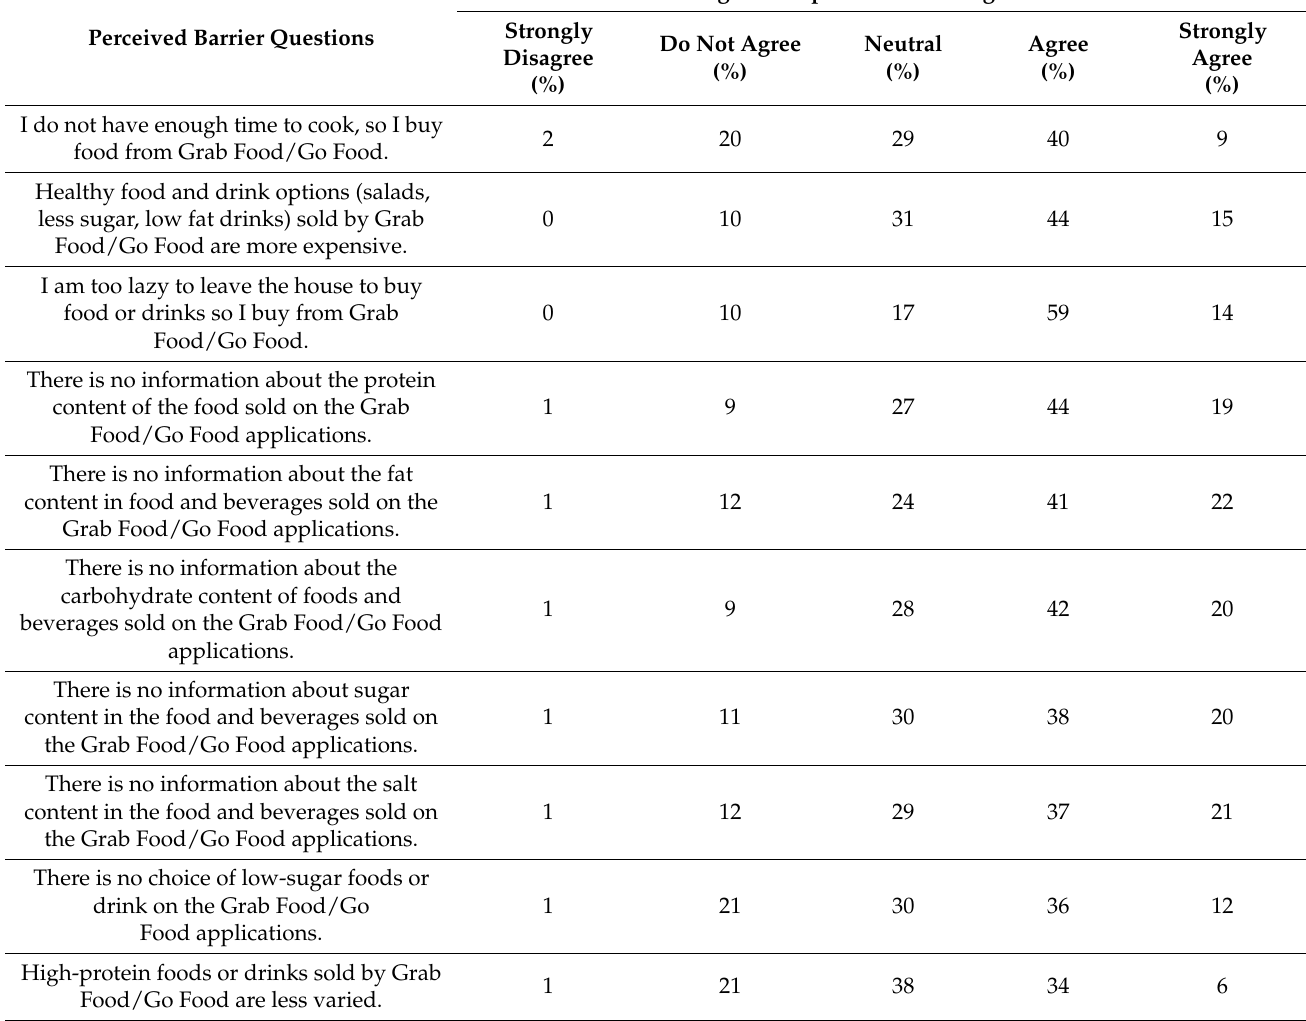
Table 7. Perceived barrier